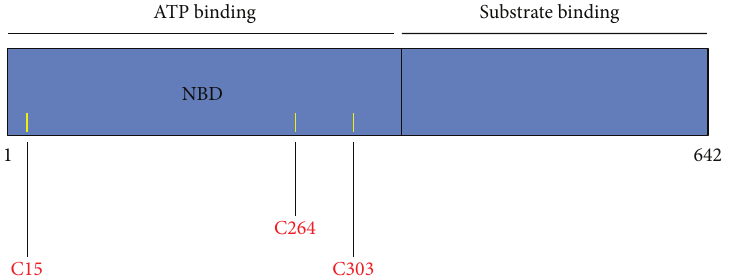
F5: DomainstructureofyeastSsa1 Hsp70.eN-terminal half oftheproteinformS thenucleotide